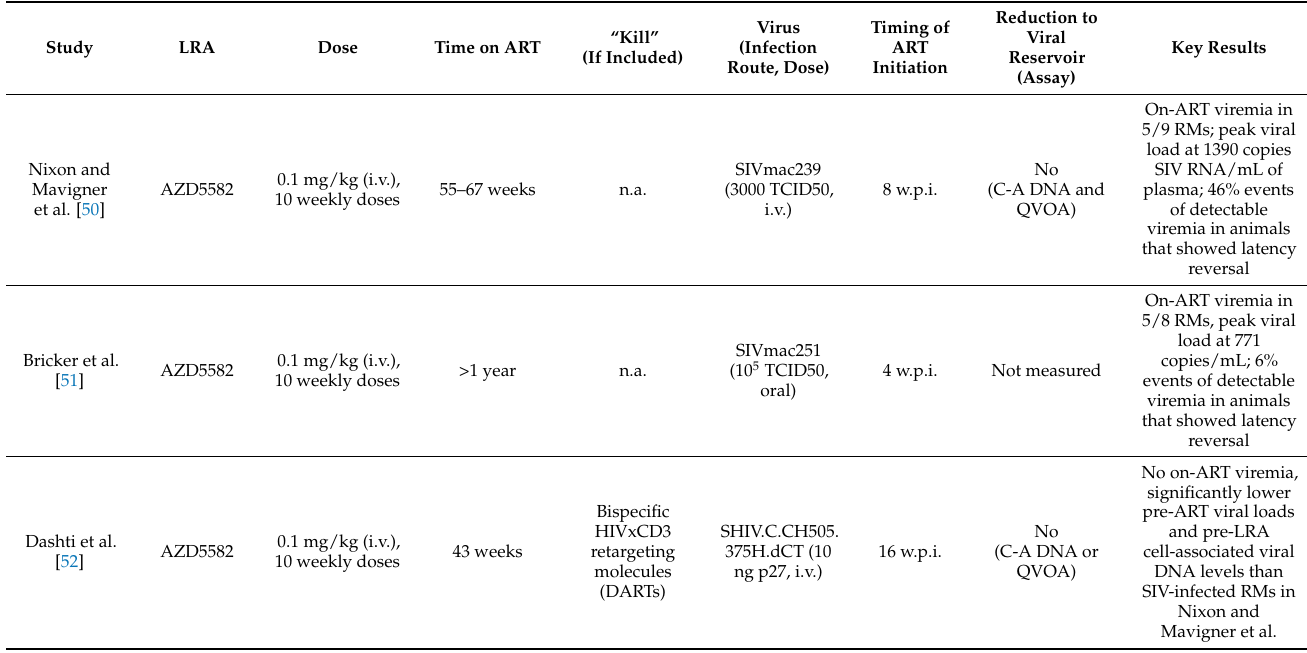
Table 1. Recent NHP studies testing AZD5582 as an LRA. w.p.i., weeks post-infection; RM, rhesus macaque; i.v., intravenous; C-A, cell-associated; QVOA, quantitative viral outgrowth